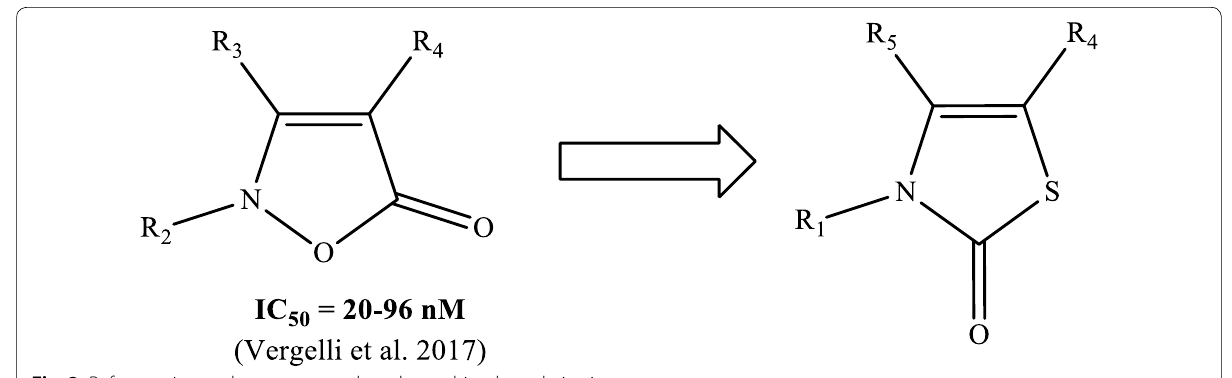
Fig. 2 Reference isoxazolone compounds and new thiazolone